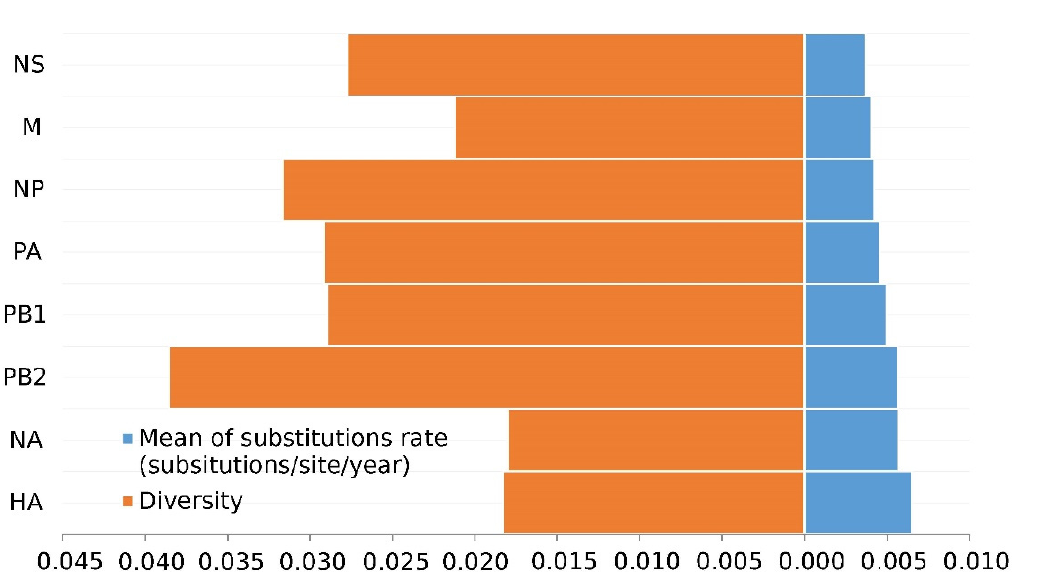
Figure 1. Diversity and evolutionary rates of H7N9 eight gene segments.